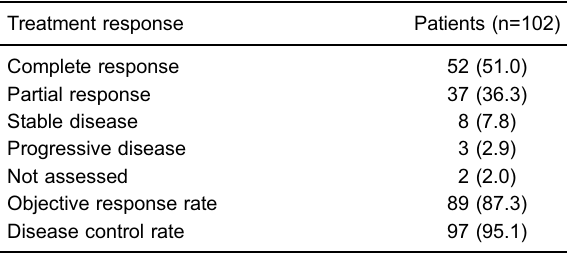
Table 1. Treatment response by drug-eluting beads transarterial